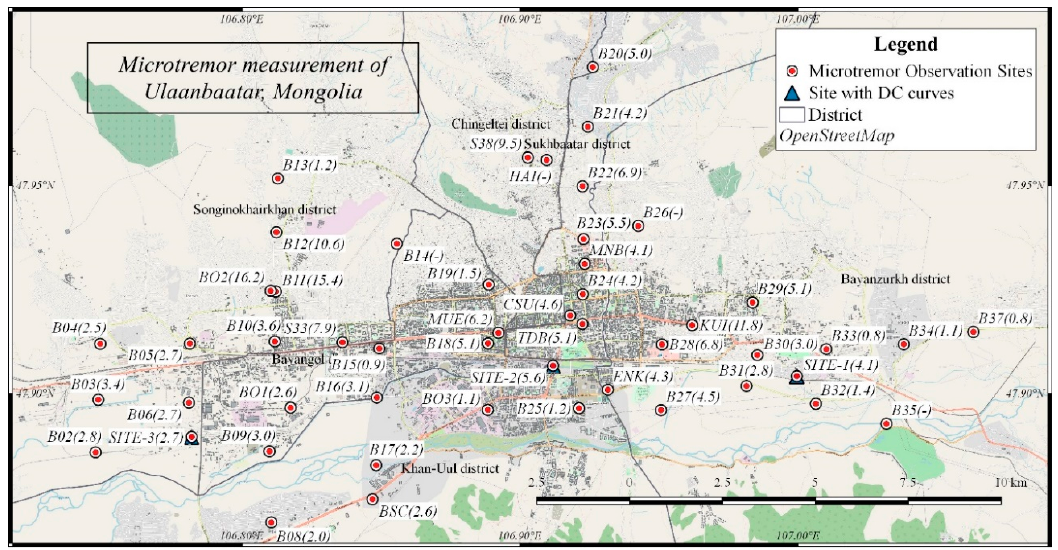
Figure 2. Microtremor observation sites in Ulaanbaatar city. Values in brackets indicate peak frequencies identified from microtremor horizontal-to-vertical ratios (MHVRs).